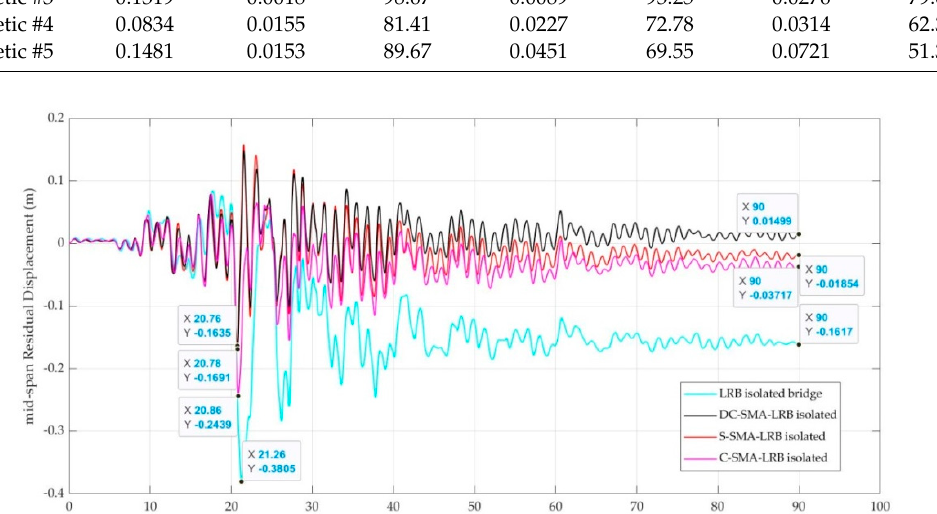
Figure 16. Time history curves of the mid-span displacement under synthetic#3 of the RSN8161 record.